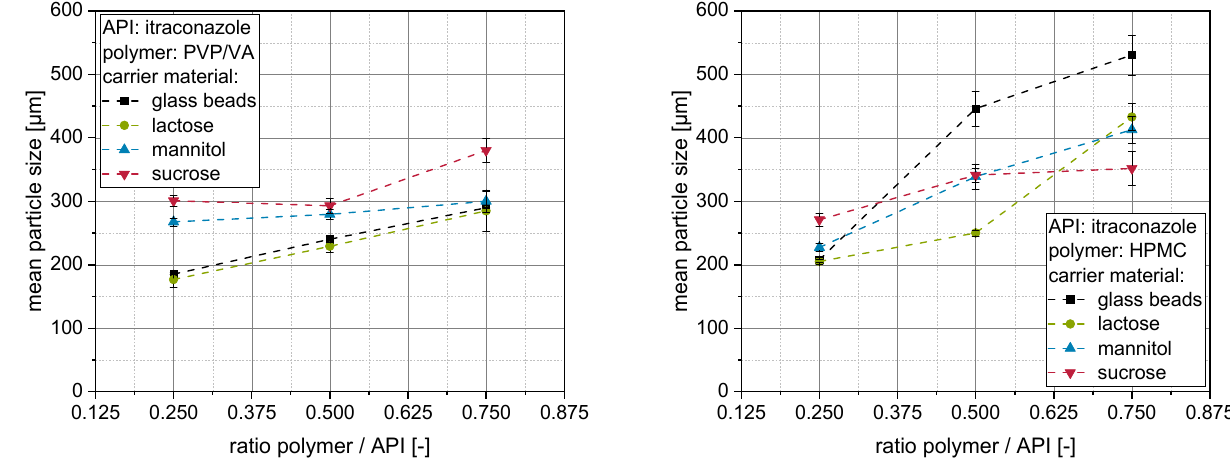
Figure 3. Mean particle size ( n = 3) of nanoparticle-loaded granules containing PVP/VA ( left ) or HPMC ( right ) as stabilizing polymer and glass beads, lactose, mannitol or sucrose as carrier mate-